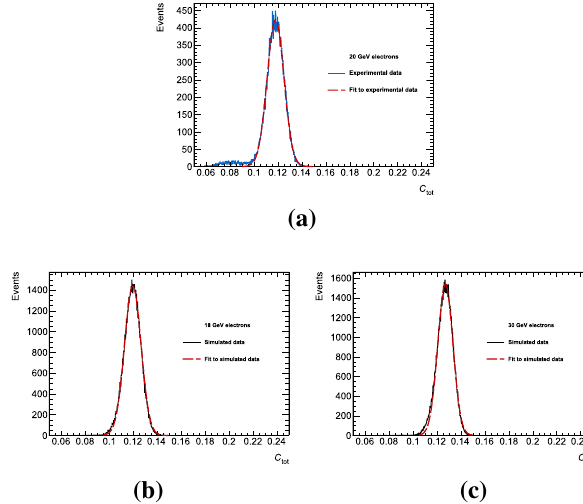
Fig. 8 Scatter plot C long vs C tot obtained using simulated 18 GeV electrons ( a ), 18 GeV pions ( b ), 30 GeV electrons ( c ) and 30 GeV pions ( d ) beams. The color scale indicate the number of events in the bins